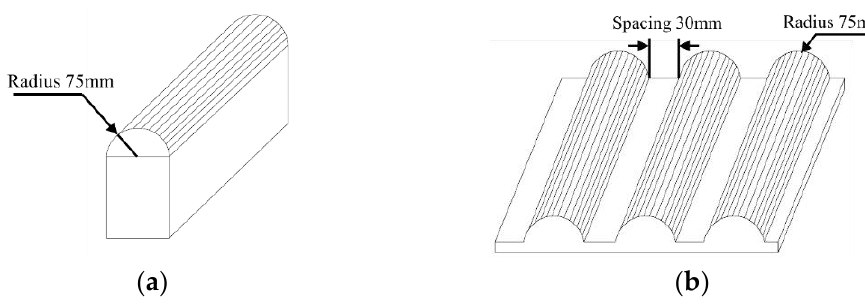
Figure 2. Schematic diagram of the crushing plate: ( a ) form 1; ( b ) form 2.